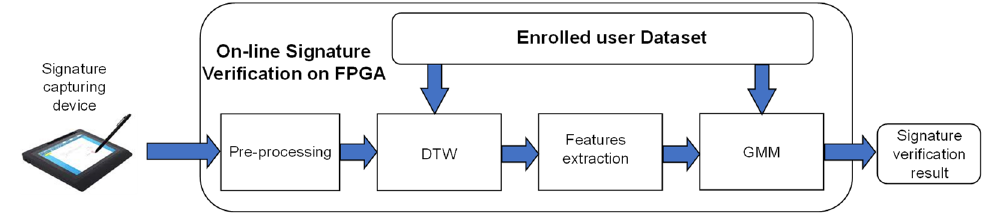
Figure 1. Overview of the online signature verification algorithm.